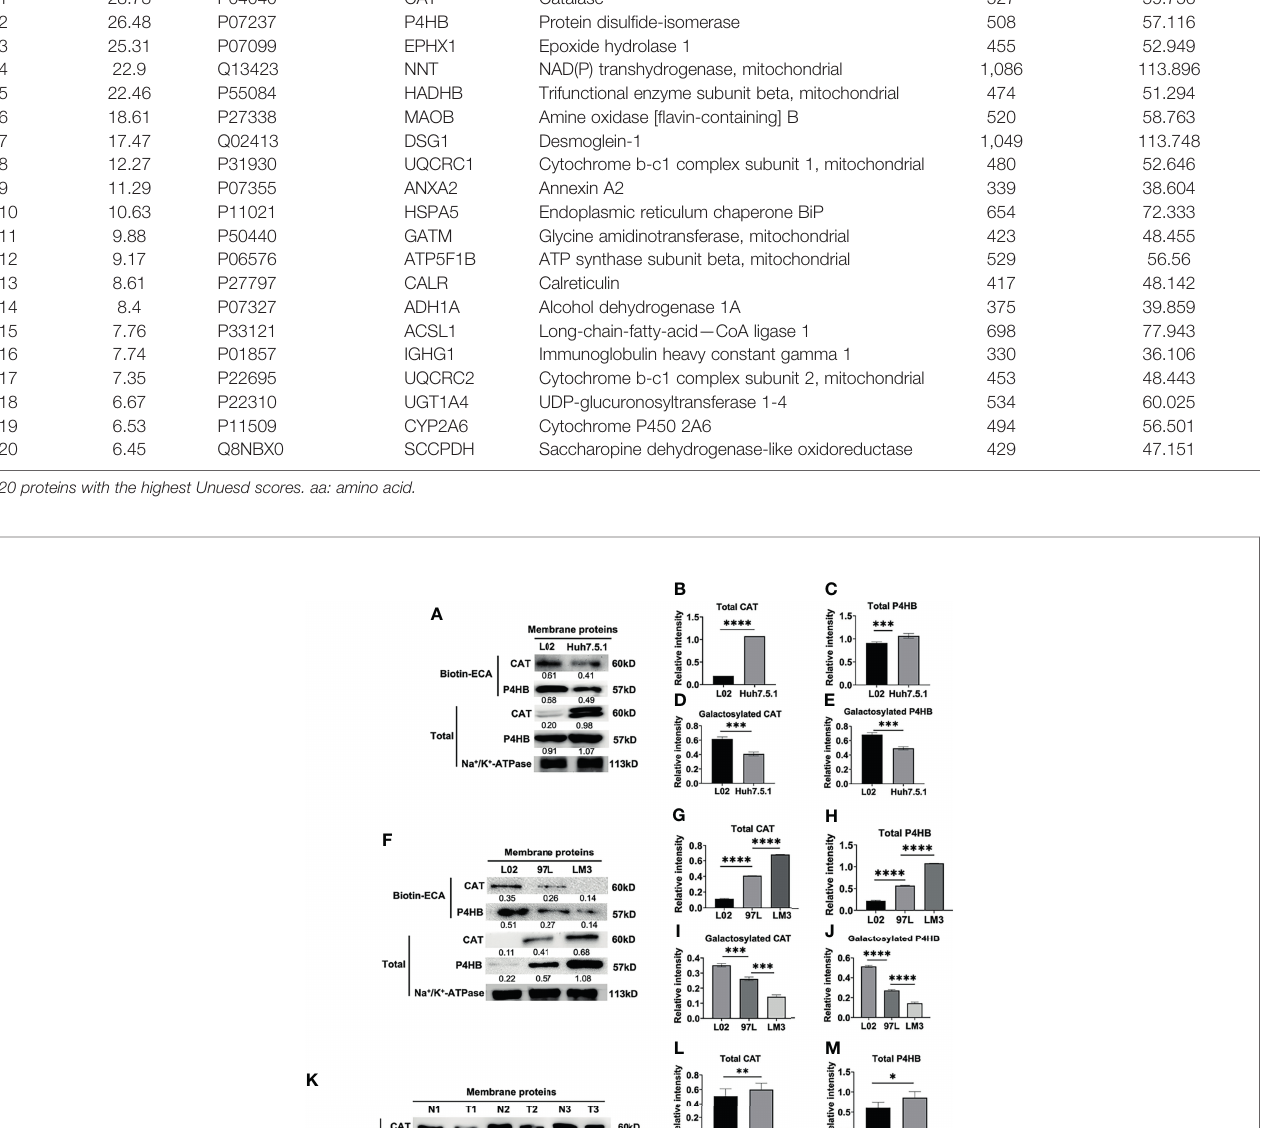
TABLE 5 | Major results of the mass spectrometry analysis.